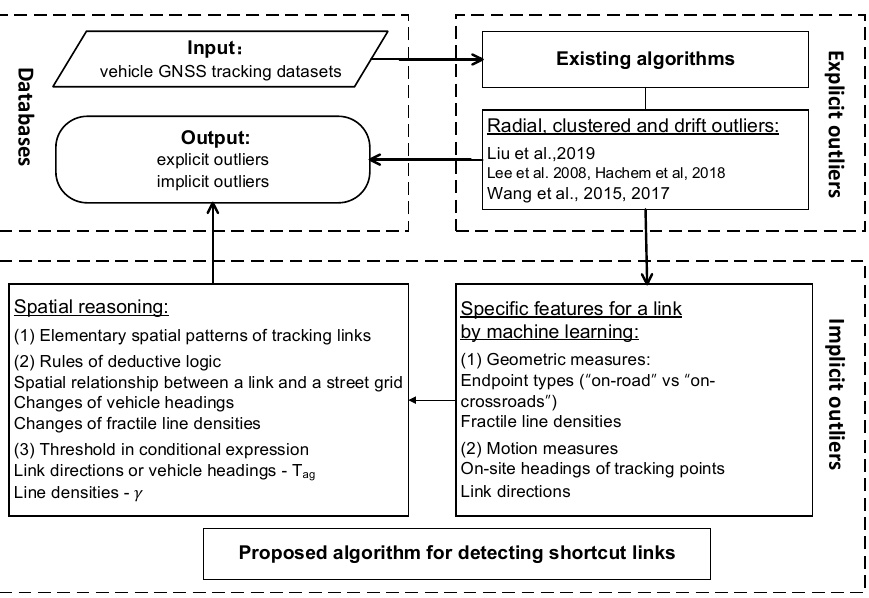
Figure 2. An integrated approach for the detection of outlier tracking